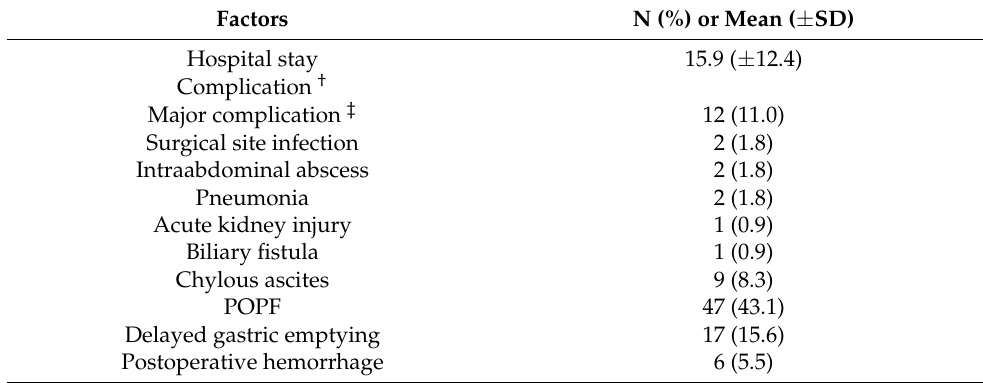
Table 5. Postoperative